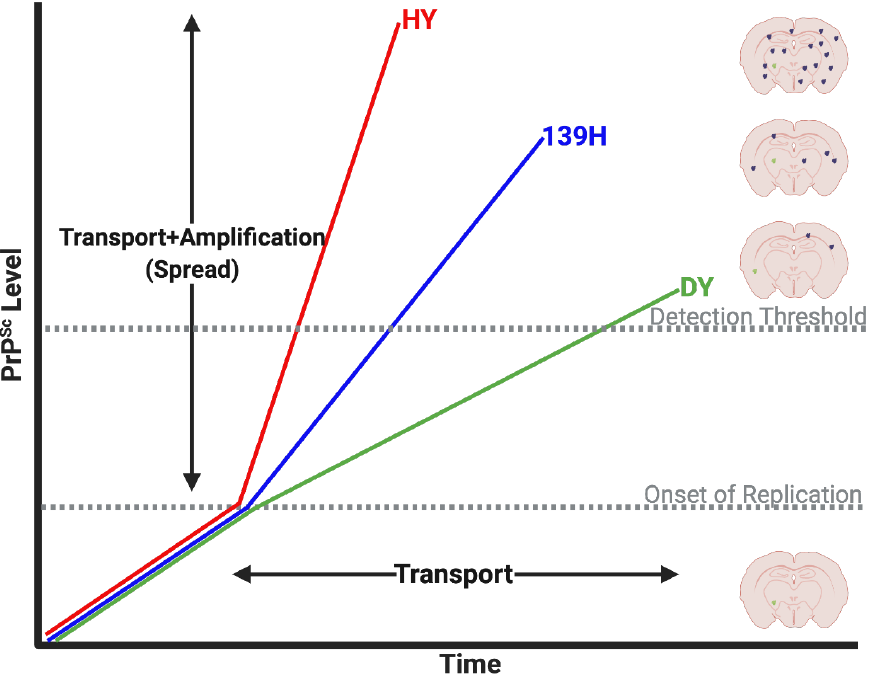
Figure 4. Prion Transport and Spread. PrP Sc can traffic to its target directly (transport) or can convert endogenous PrP C anywhere along the pathway and amplify (spread). Currently, detection methods such as immunohistochemistry (IHC) or Western blot (WB) can only measure the spread of PrP Sc because threshold levels of PrP Sc are required for successful detection. Moreover, this spread has been demonstrated to vary between prion strains and can influence calculation of transport/spread. More sensitive measurement techniques can approximate transport more accurately (requires lower PrP Sc threshold for detection or even directly measure PrP Sc transport). Note: Light green dots in coronal brain sections represents the original inoculum PrP Sc , while the black dots represent newly replicated PrP Sc . Image created with BioRender.com, accessed on 15 March 2022.